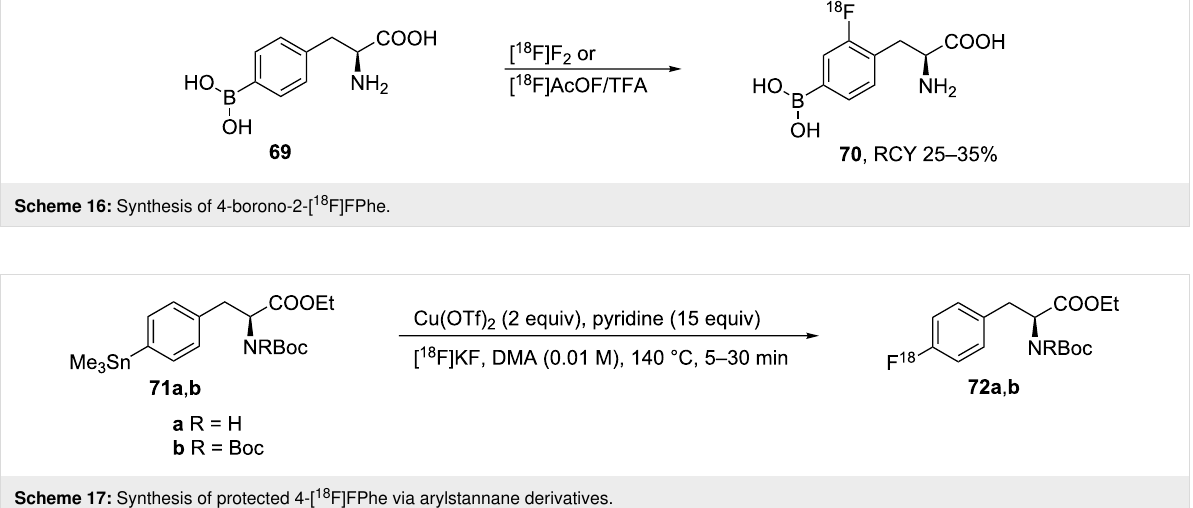
Scheme 17: Synthesis of protected 4-[ 18 F]FPhe via arylstannane